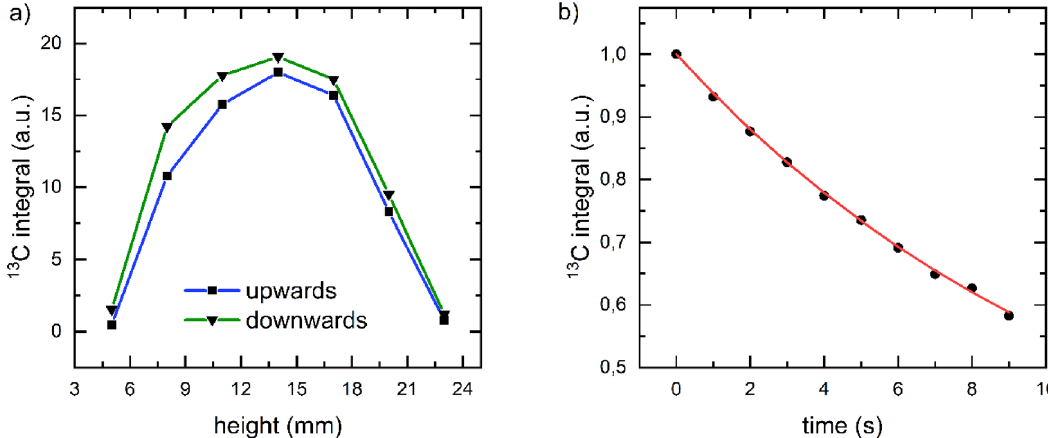
Figure 3. Calibration of the sample position and flip angle. ( a ) DNP-enhanced, solid-state 13 C-NMR signal of pyruvate as a function of the position of the sample in probe. To ensure sufficient signal, the sample was first polarized for 40 min. Then the 13 C signal was acquired at different positions x s every minute using a low flip angle of 2°. Moving the sample first down, then up, a broad maximum around x s = 14 mm was found. Straight lines were plotted to guide the eye. ( b ) DNP-enhanced 13 C NMR signal acquired by a train of p RF d = 2